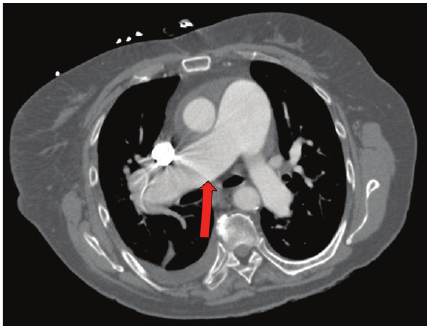
Figure 2: CT-scan showing enlarged pulmonary artery (red arrow).